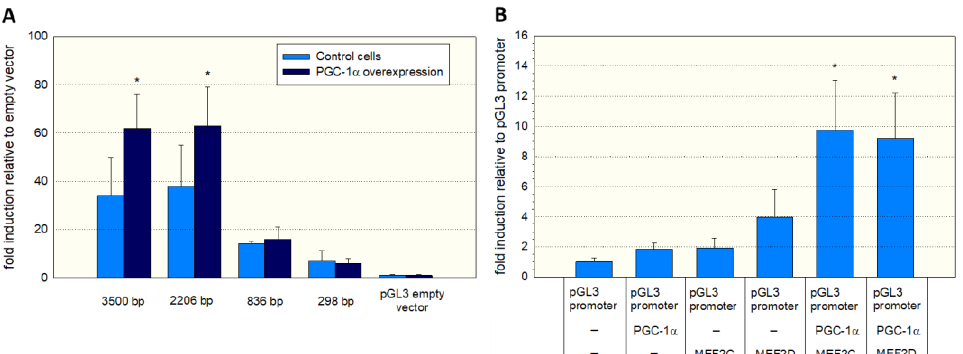
Figure 3. Functional analysis of the SLC22A5 gene promoter. ( A ) C2C12 myoblasts were transfected with different 5 ′ -truncated fragments of the SLC22A5 gene 5′ upstream region and their functionality assessed using a dual luciferase assay. The − 3256/+244 (3500 bp) and the − 1962/+244 (2206 bp) promoter segments revealed the highest reporter gene activity. Co-transfection with PGC-1 α increased the promoter activity of these segments. ( B ) C2C12 myoblasts containing the PGL3 promoter were transfected with MEF2C/D or PGC-1 α and a combination of both. The highest promoter activity was achieved in C2C12 cells with combined transfection with PGC-1 α and MEF2C or MEF2D. Data are presented as the mean ± SD of n = 5 independent observations. * p < 0.05 cells with PGC-1 α overexpression vs. control cells without PGC-1 α overexpression ( A ) and p < 0.05 vs. cells expressing the pGL3 promoter ( B ).